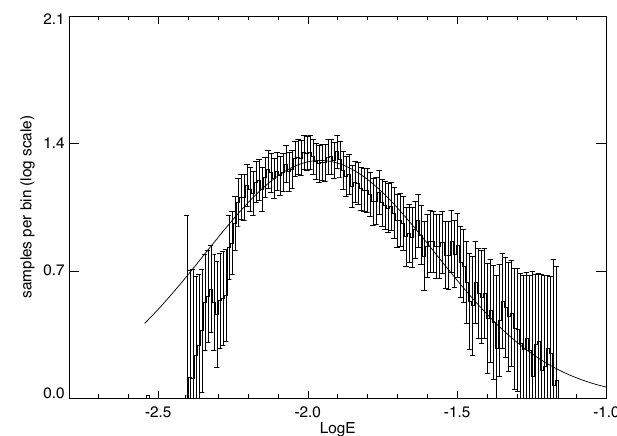
Fig. 4. Histogram for event 2 corresponding to 2.6ms width for the running average. The x-axis is the logarithm of the electric field amplitude while the y-axis is the logarithm of the number of occurrences. Error bars indicate the statistical uncertainty based on counting statistics, as explained in the text.